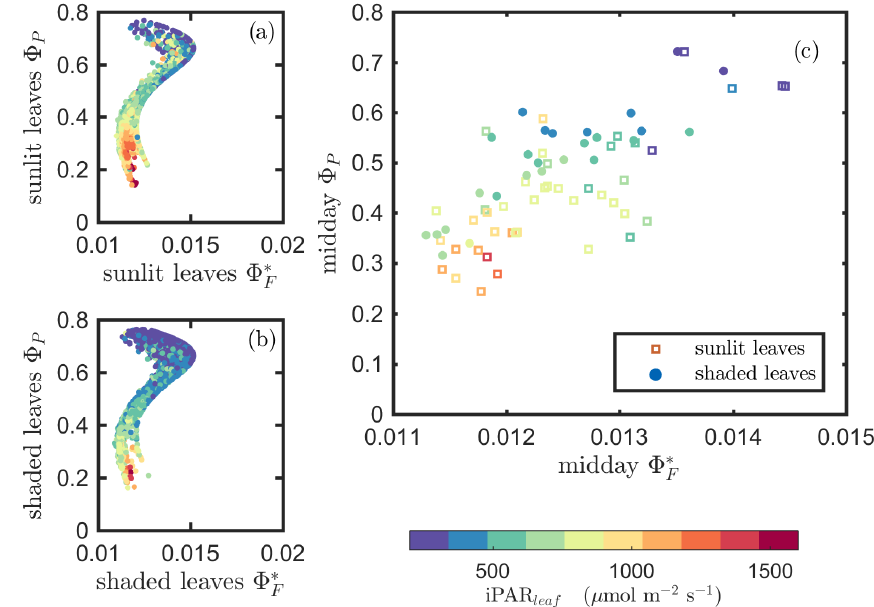
Figure 9. Reproduction of Fig. 6 with simulated variables from the biochemical model of van der Tol et al. (2014).